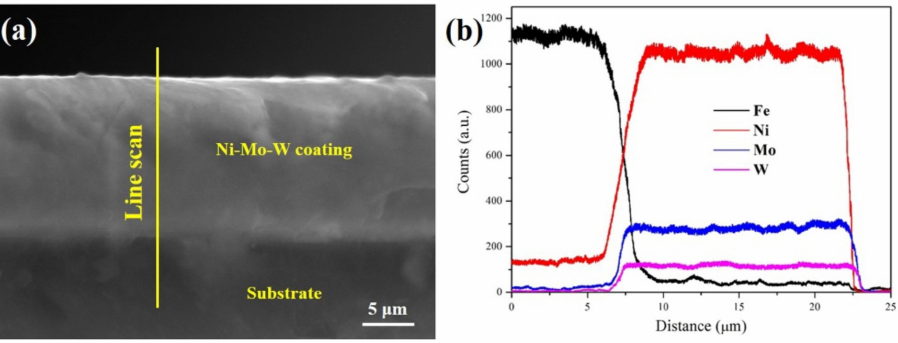
Figure 2. ( a ) The cross-section of SEM micrographs of the representative 600 ◦ C annealed Ni-Mo- W coating and ( b ) with corresponding qualitative chemical analysis (EDS) along the line of scans (profiles of Ni, Mo, W and Fe